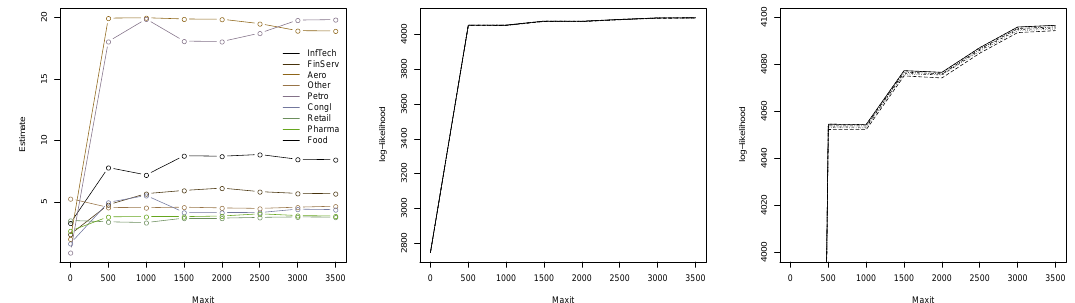
Figure 6. Estimated dof for a grouped t copula fitted to the standardized residuals obtained from the Dow Jones 30 dataset from 1 January 2014 to 31 December 2015 after deGARCHing ( left ); estimated log-likelihood of the estimated dof on the middle and right plot.